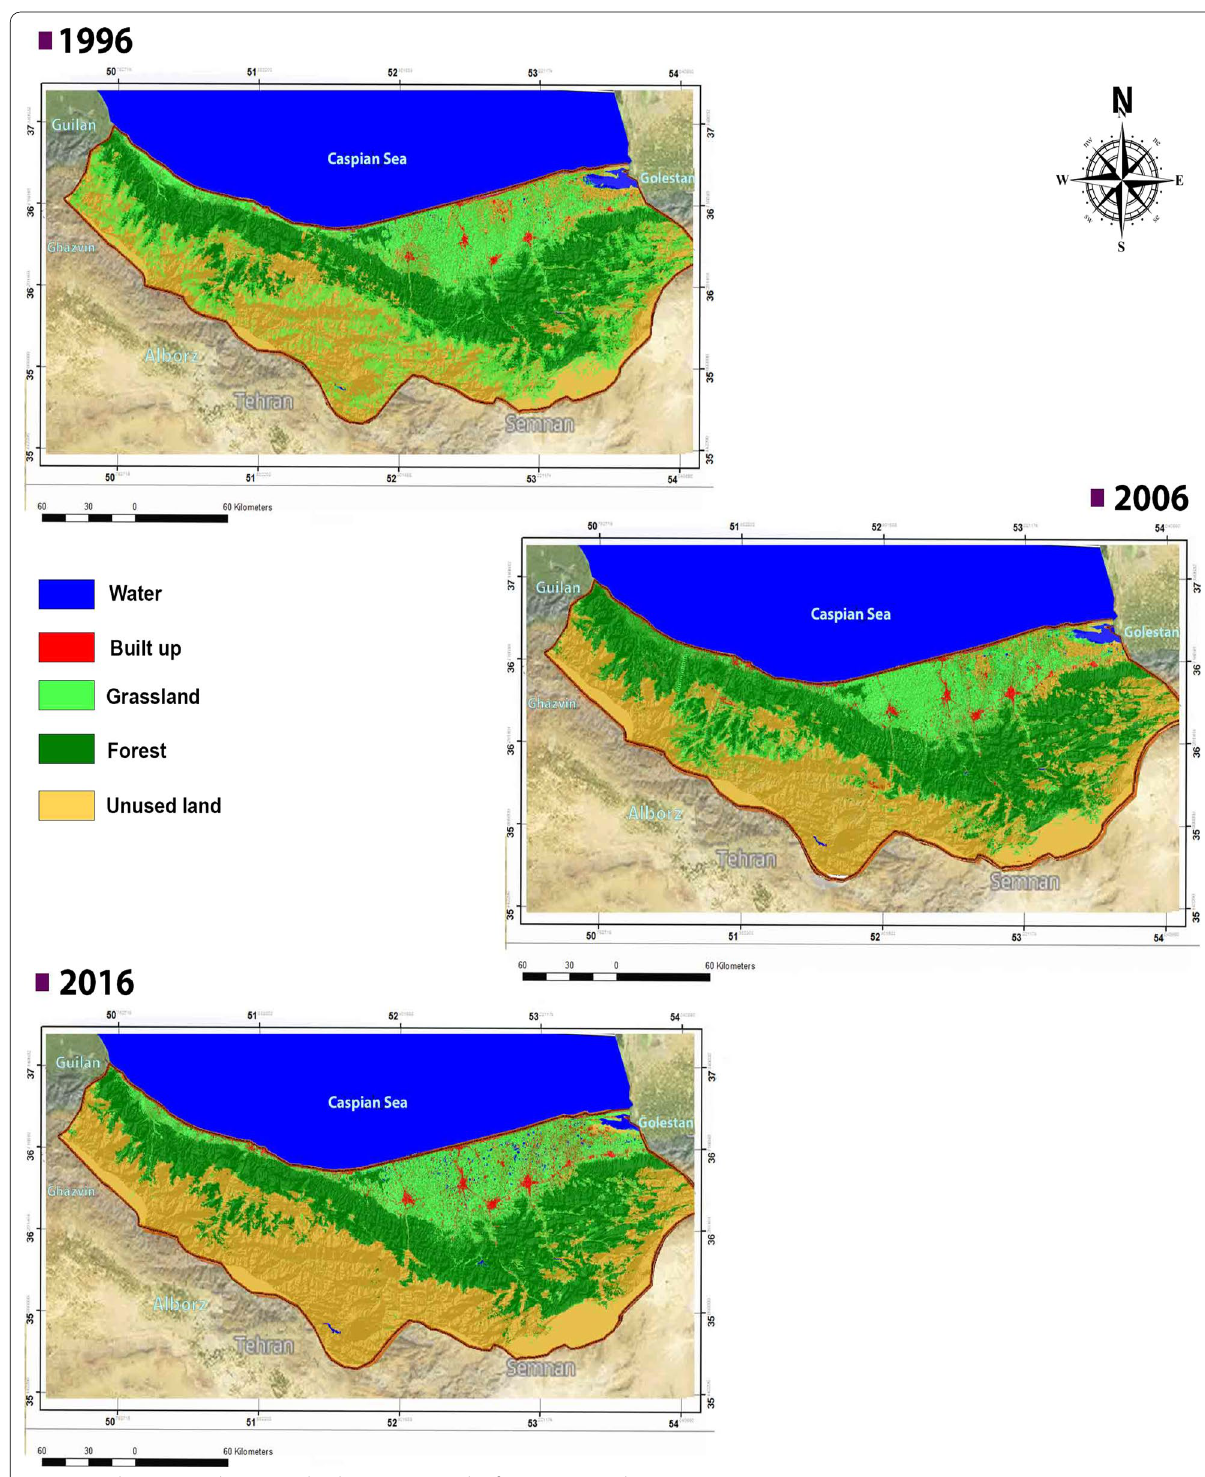
Fig. 3 Land use/cover changes in the three time periods of 1996, 2006, and